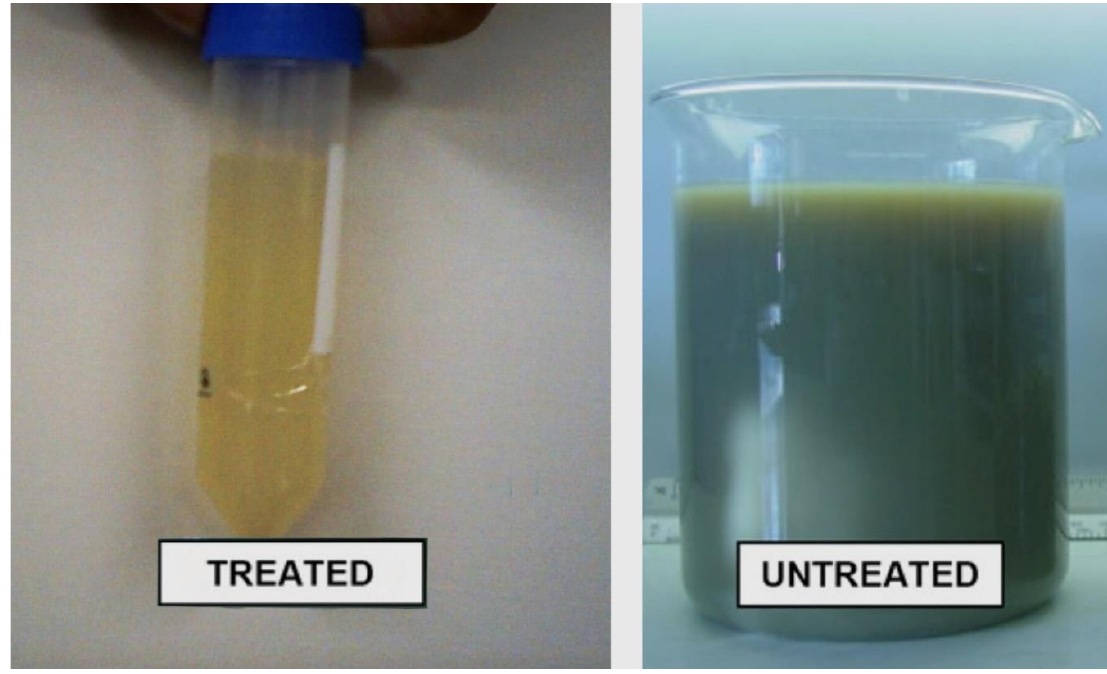
Figure 3. The appearance of the aeration wastewater before and after the treatment.